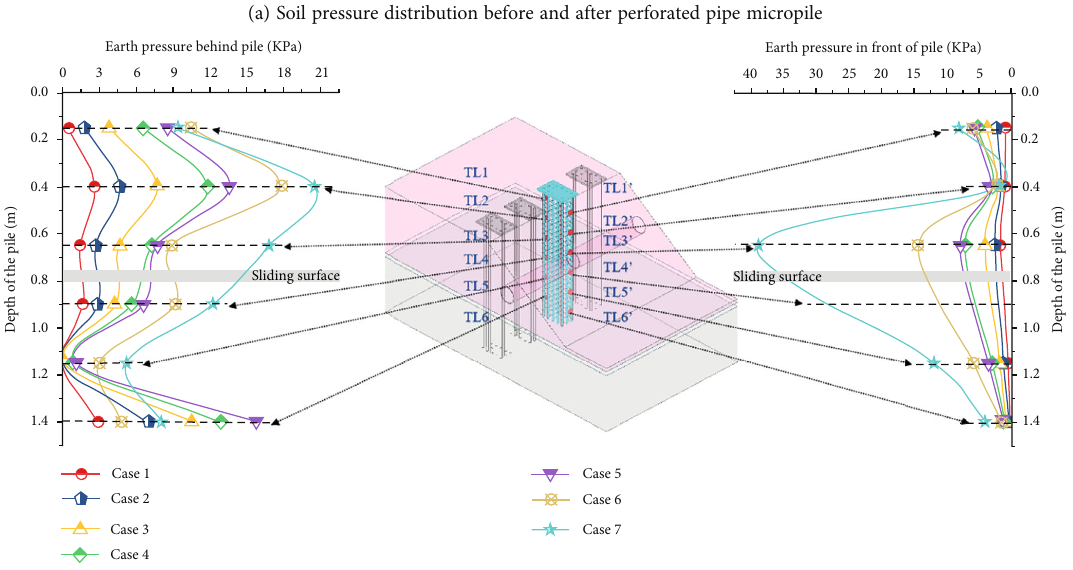
(b) Soil pressure distribution before and after screw micropile Figure 10: Distribution of earth pressure around